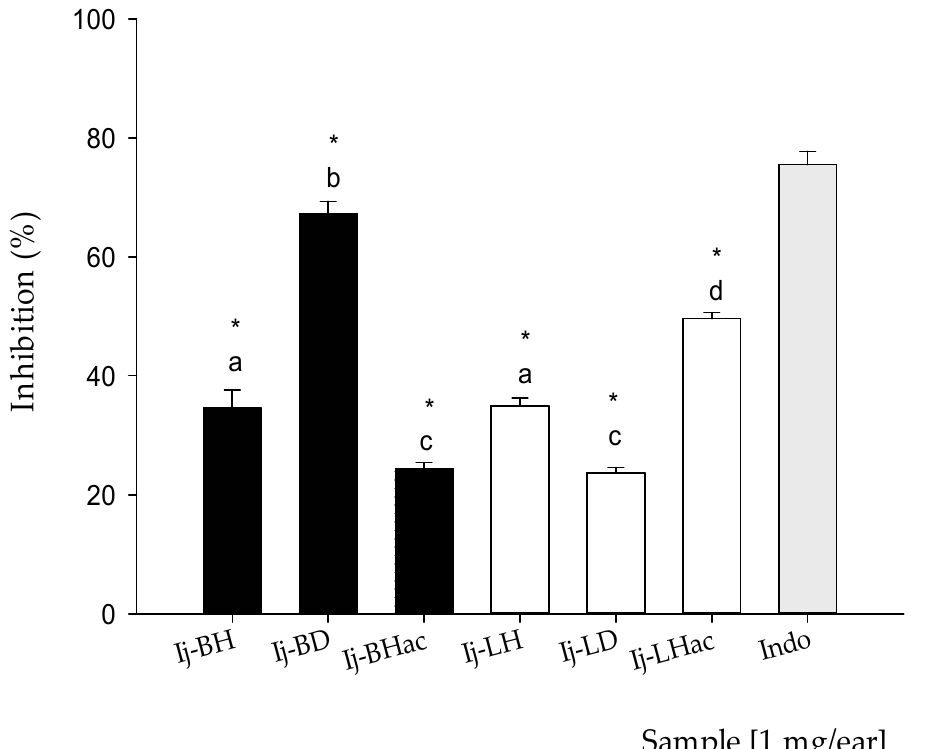
Figure 3. Percentage inhibition of inflammation (%) of Ij-BH , Ij-BD , Ij-BHac , Ij-LH , Ij-LD , and Ij-LHac extracts from Inga jinicuil and Indo (Indomethacin) in edema induced by TPA in mouse ear at 1.0 mg/ear. Values are presented as means ± standard error of the means (SEM). n = 5. ANOVA, with post-test Dunnet with * p ≤ 0.05 in comparison with Indo and Tukey test, where different letters indicate significant differences among them.